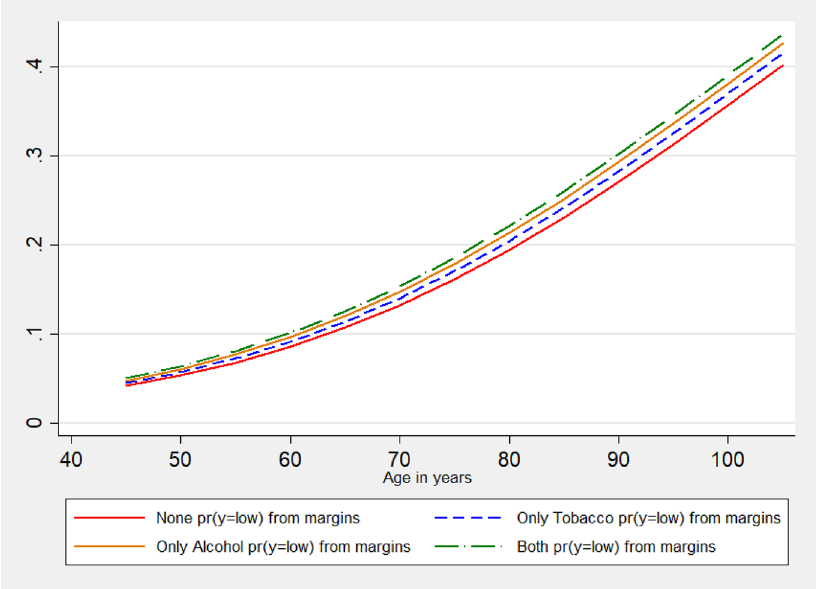
Figure 4. Average marginal effects of age on low cognition by substance use pattern among older adults, LASI, Wave 1, 2017–2018.